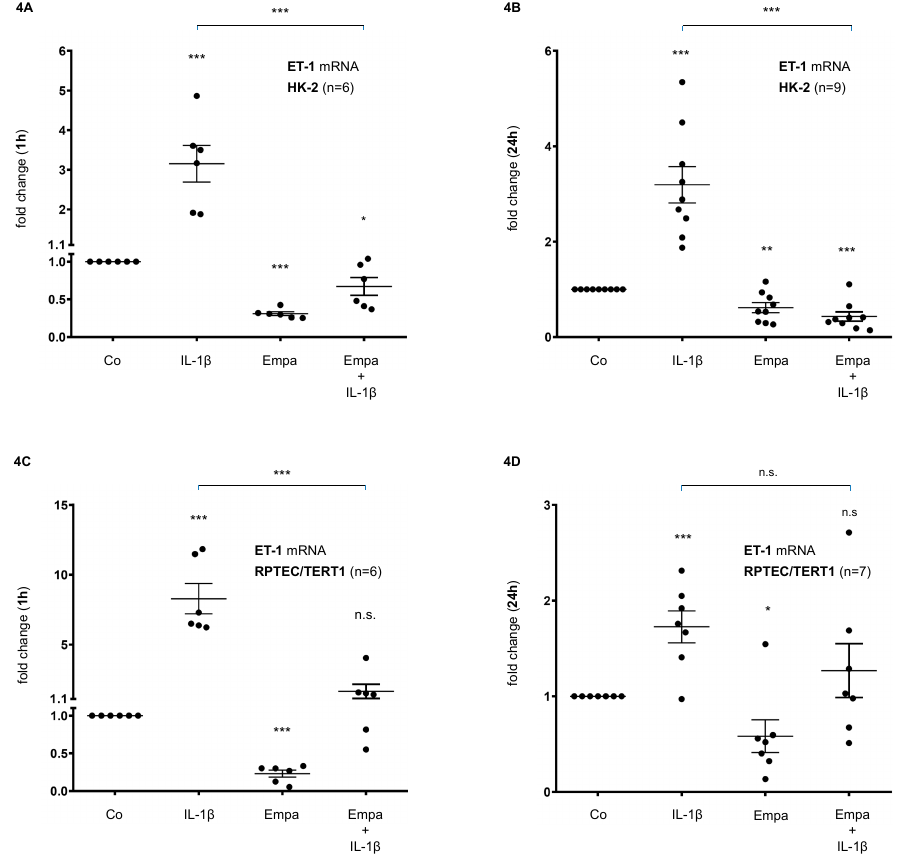
Figure 4. Inhibitory effect of empagliflozin on basal and IL-1 β -induced ET-1 mRNA expression in human proximal tubular cells. HPTCs were serum- and supplement-starved for 24 h and then stimulated for 1 h ( A , B ) or 24 h ( C , D ) with IL-1 β (10 ng/mL), 500 nM Empa, or a combination of Empa (500 nM) and IL-1 β (10 ng/mL). Controls (Co) were left unstimulated for 1 h ( A , C ) or 24 h ( B , D ). Data are presented as fold induction above ET-1 control levels after normalizing to GAPDH expression. For each experimental condition, data of (n) independent experiments are presented as dots in scatter plot graphs with the respective mean ± SEM bars. ( A , B ) In HK-2 cells, IL-1 β (10 ng/mL) stimulated ET-1 mRNA expression 3-fold (*** p < 0.001, each, when compared with unstimulated control cells) after 1 h ( A ) and 24 h ( B ) of ligand stimulation, respectively. Empa (500 nM) downregulated basal ET-1 mRNA expression by 0.3-fold and 0.6-fold after 1 h ( A ) and 24 h ( B ), respectively (*** p < 0.001 and ** p < 0.01, respectively, when compared with unstimulated control cells). Co-administration of Empa inhibited IL-1 β -mediated ET-1 mRNA expression after 1 h (0.2-fold, *** p < 0.001) ( A ) and 24 h (0.1-fold, *** p < 0.001) ( B ). cDNA from n = 6 ( A ) and n = 9 ( B ) independent RNA isolations was used for real-time PCR analysis, respectively. ( C , D ) In RPTEC/TERT1 cells, IL-1 β (10 ng/mL) stimulated ET-1 mRNA expression 8-fold and 1.7-fold after 1 h ( C ) and 24 h ( D ) of ligand stimulation, respectively (***